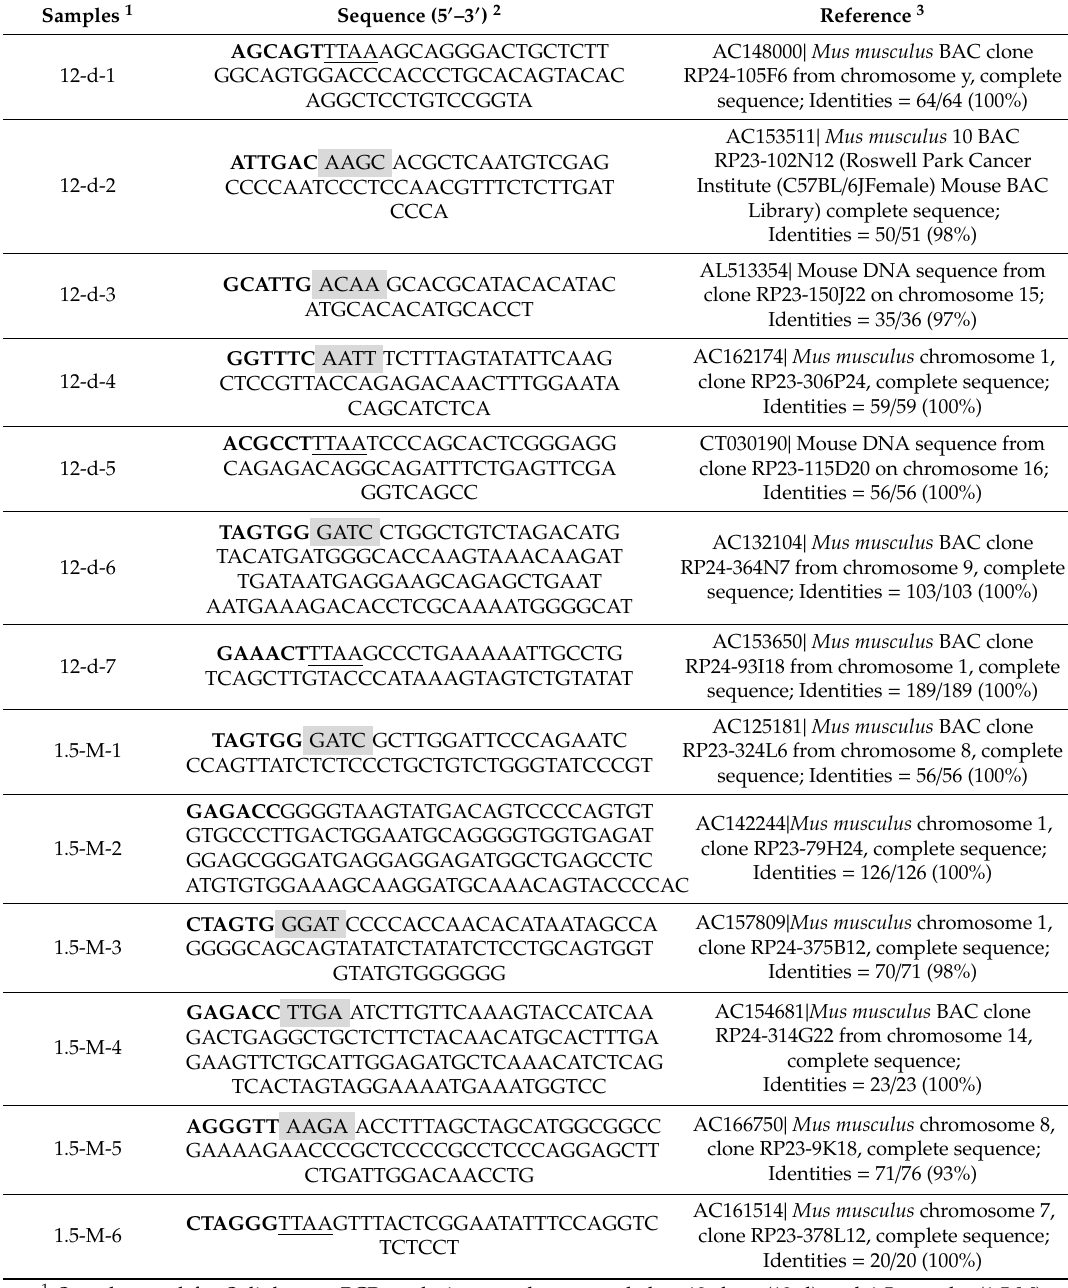
Table 1. Splinkerette-PCR